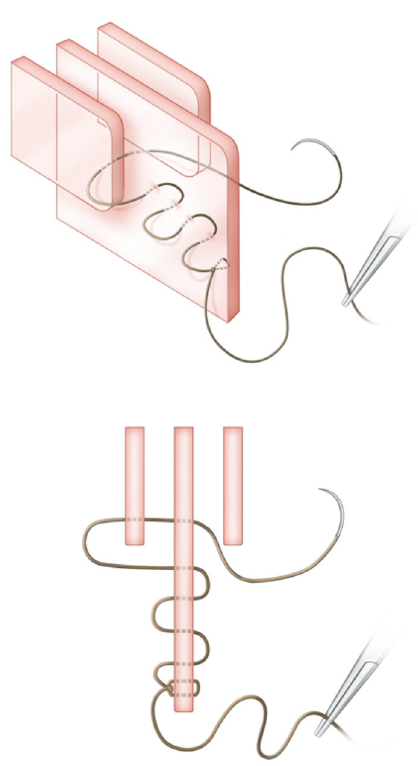
Figure 3: Oblique and axial views. Step 3. An initial pass is made incorporating the right MT and the septum alone. The needle tip is then grasped on the left side between the septum and left MT.